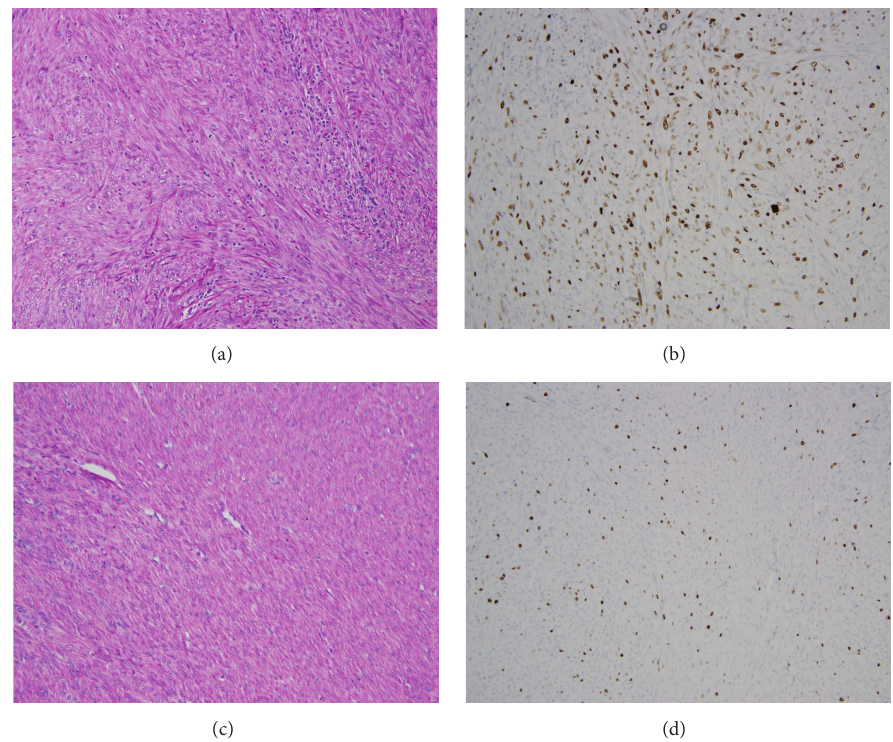
Figure 1: (a) Bladder leiomyosarcoma, H/E 200x: sheets of spindle shaped cells with disordered architecture and multiple mitotic figures. (b) Bladder leiomyosarcoma, MIB-1 immunohistochemistry, 200x: extensive MIB-1 positive cells showing high proliferative activity. Cells were also Rb, SMA, desmin, and vimentin positive, while negative results were obtained with S-100, melanin cocktail, CD117, and CD10. (c) Uterine leiomyosarcoma, H/E 200x: well-differentiated extensive low-grade leiomyomatous architecture with few mitotic figures. (d) Uterine leiomyosarcoma, MIB-1 immunohistochemistry, 200x: lower MIB-1 proliferative activity showing low-grade malignancy positive for ER and PR and negative for Rb and